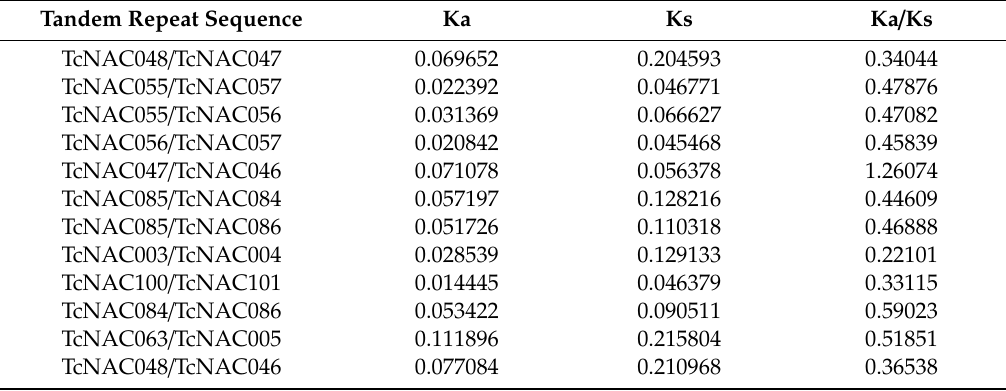
Table 1. The Ka / Ks values of Theobroma cacao tandem repeat